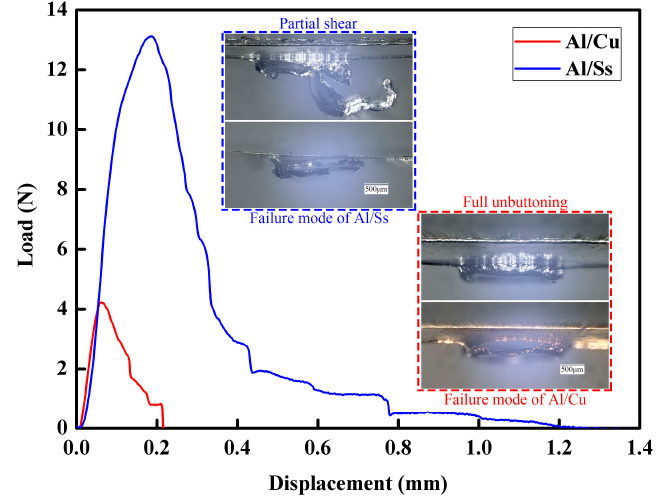
Figure 14. Load-displacement curves measured from single lap shearing tests.